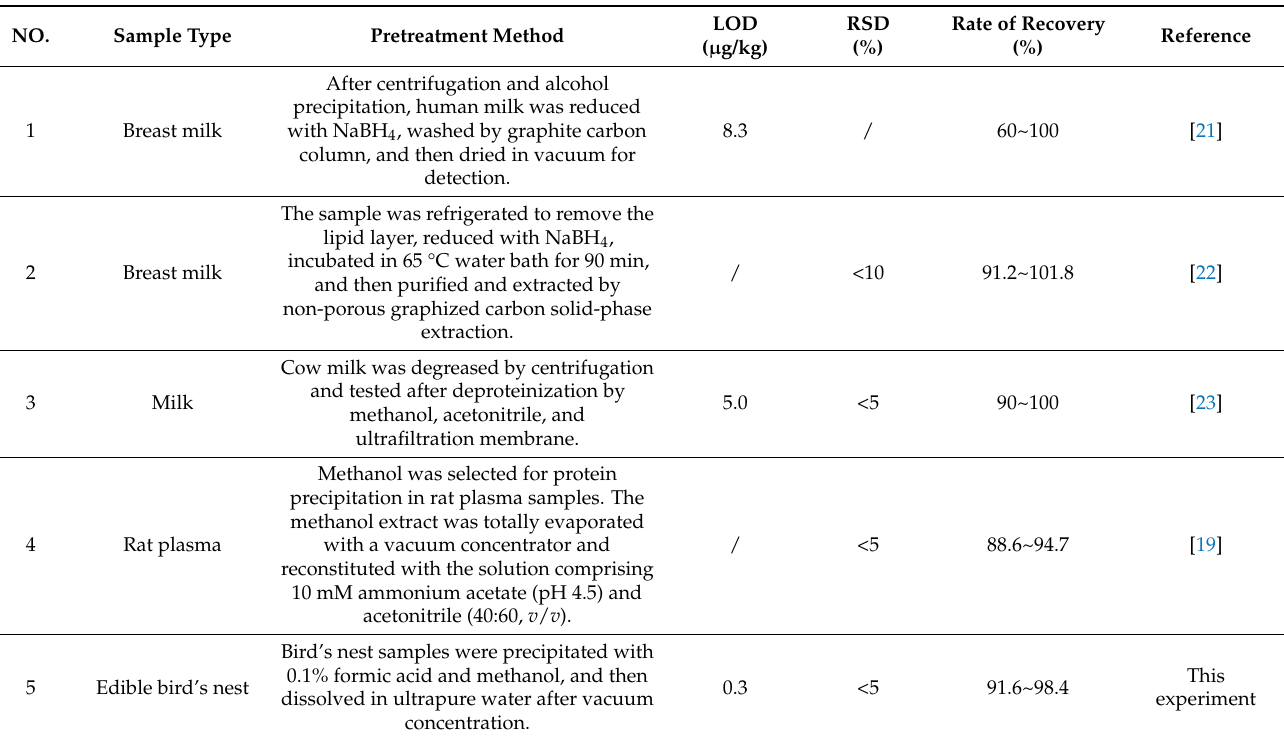
Table 1. Comparison of liquid chromatography–mass spectrometry methods for 3 (cid:48)